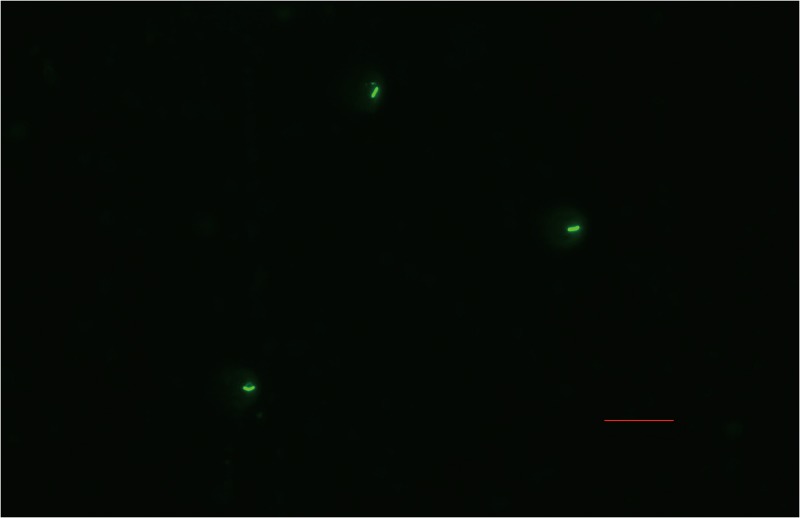
Cells of Bacillus subtilis strain 1-L-29gfp under a fluorescence microscope (40 × magnification).